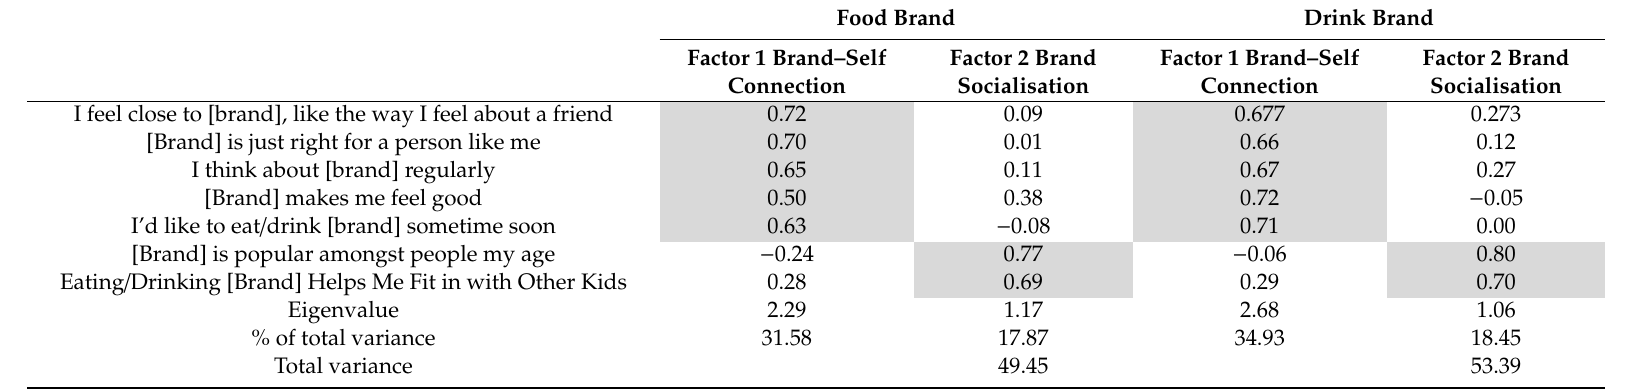
Table 3. Component loadings for seven survey items for food and drink brands.